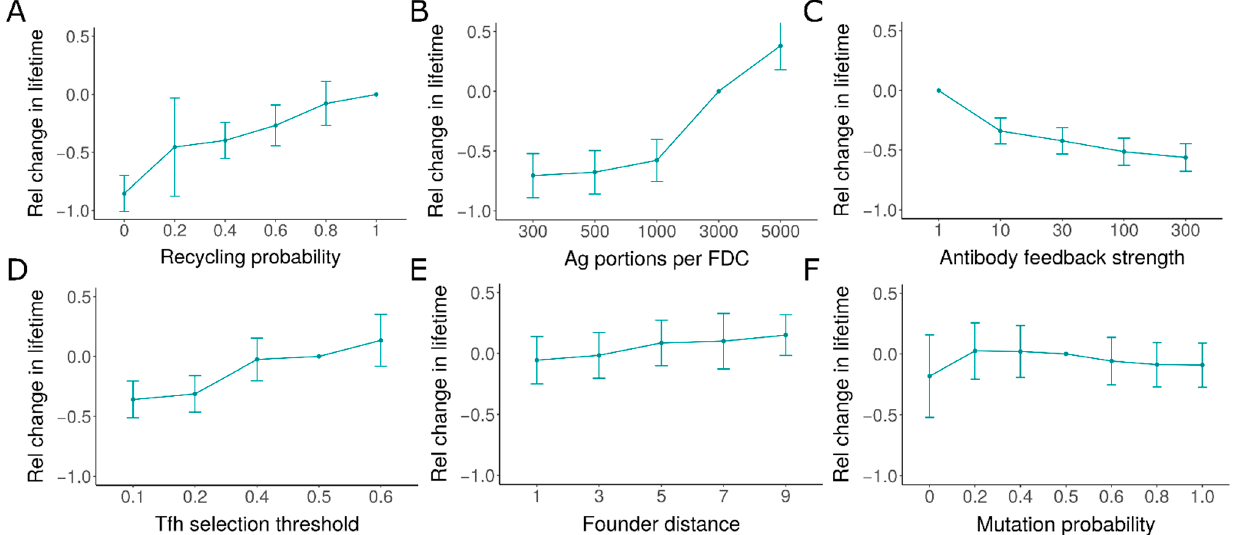
Figure 3. Variability in GC lifetime with varying parameter values: ( A ) probability of recycling, ( B ) antigen portions loaded in each FDCs, ( C ) strength of antibody feedback, ( D ) signal threshold required for selection by Tfh, ( E ) distance of founder cells in shape space from optimal position representing affinity to antigen, ( F ) mutation probability. Changes in lifetime were normalized with respect to the GC lifetime in simulation with reference parameter values (Supplementary Table S1).